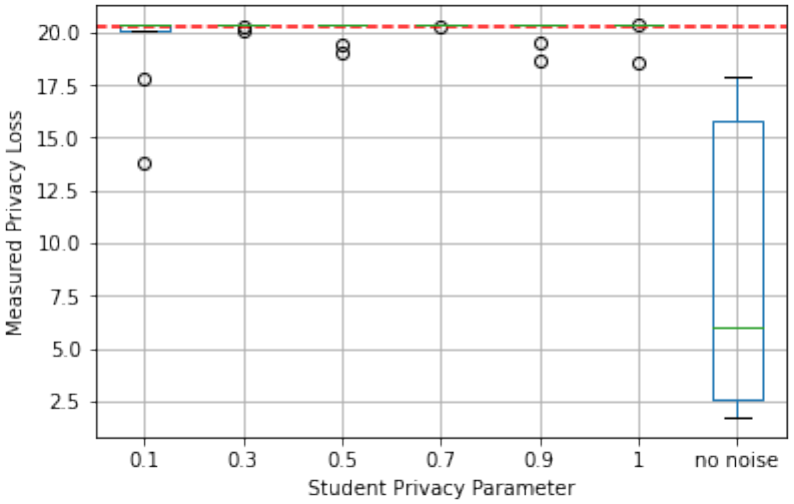
Figure 10. Validation accuracy by student privacy parameter ρ in ECG dataset.